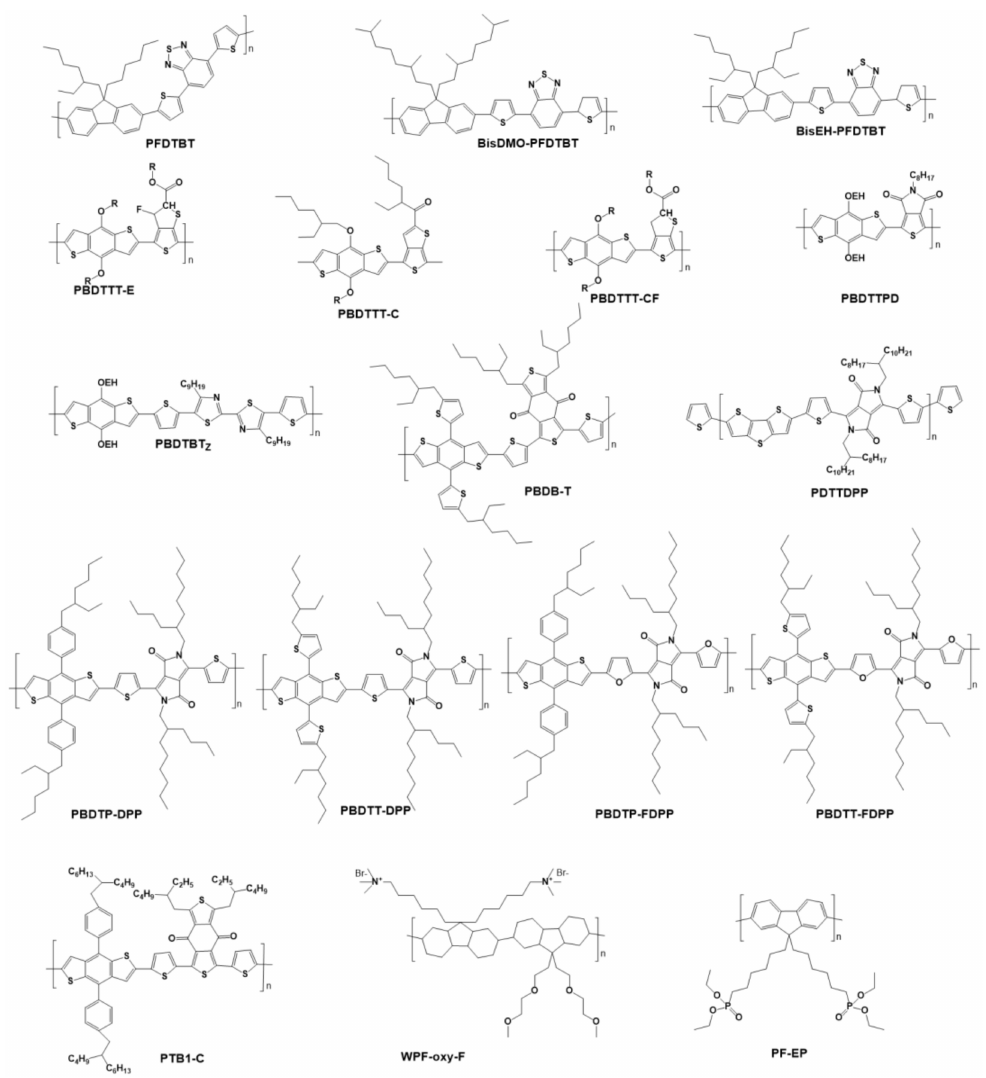
Figure 16. Molecular structures of materials for photoactive